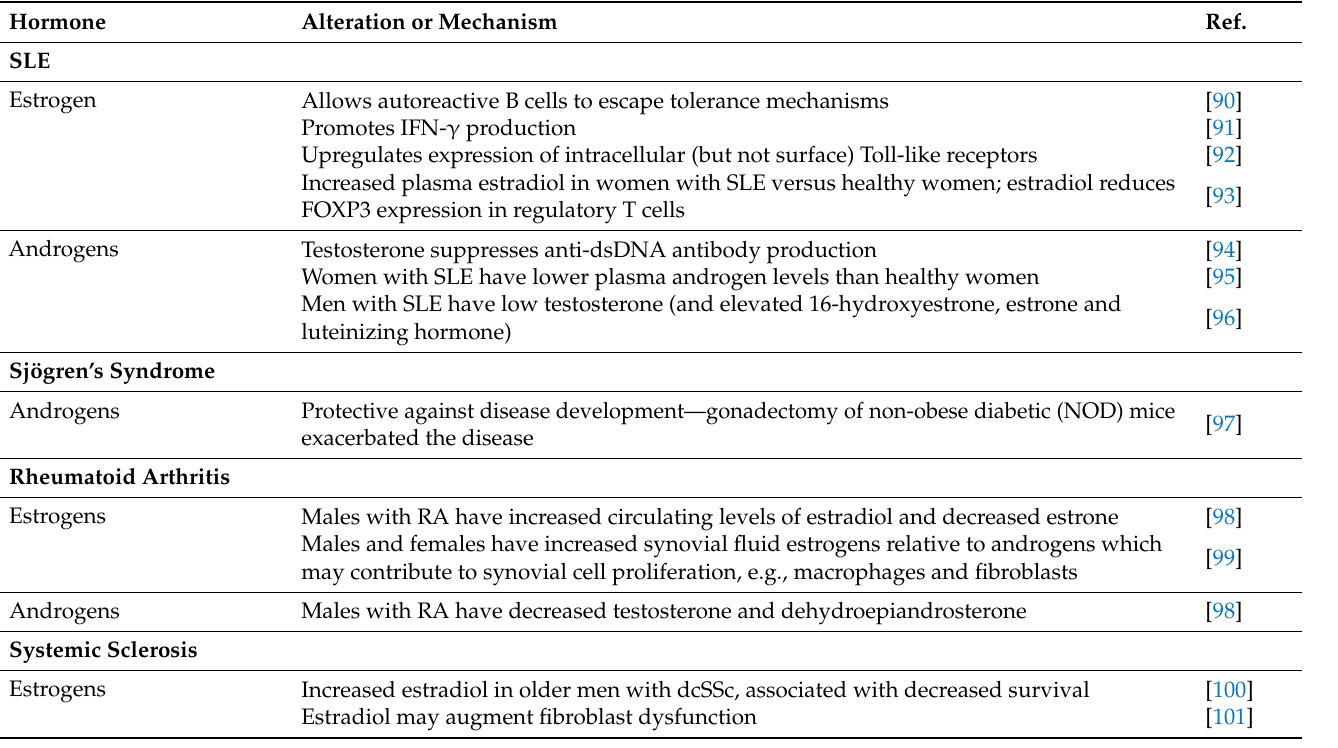
Table 2. Sex hormone effects on CTD